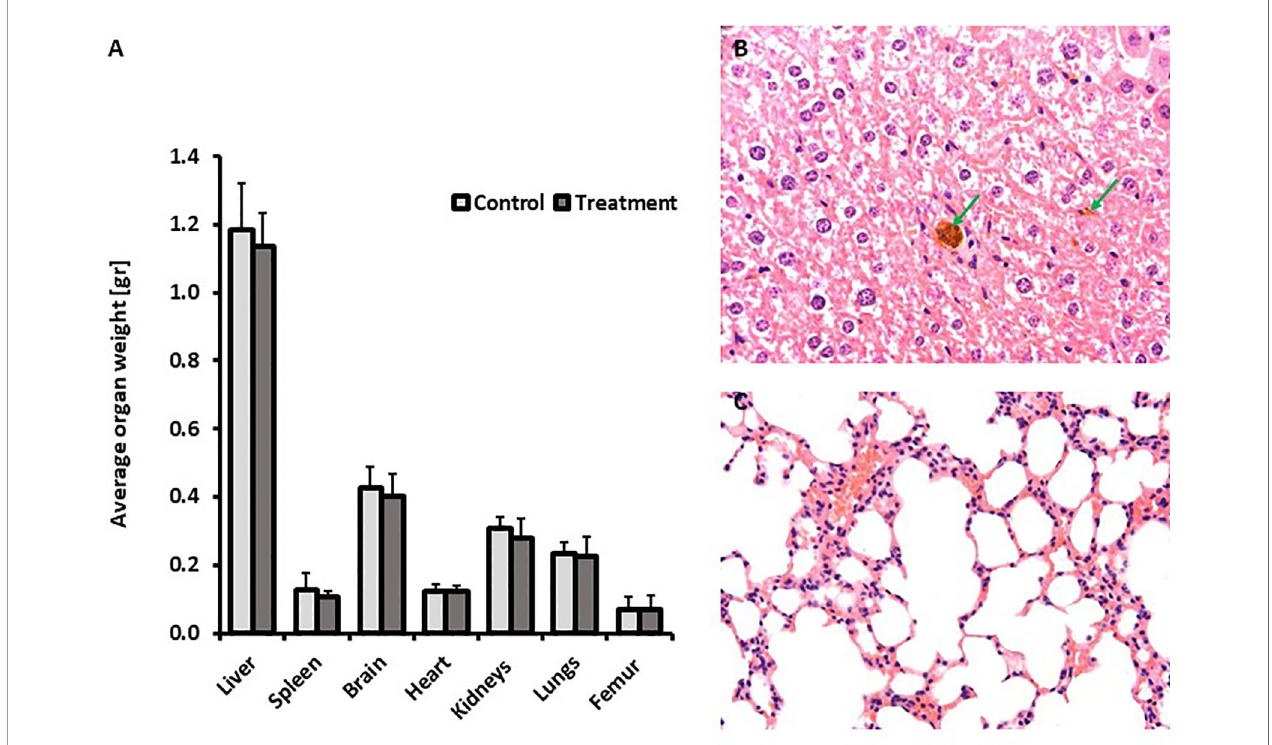
FIGURE 5 | Repeated dose chronic toxicity study. (A) Average organ weight after a follow up period of 25 weeks. (B) Representative liver section (H&E staining) from a treated mouse at 25 weeks post treatment. Green arrows indicate pigment laden macrophages in the liver (Kupffer cells) associated with minimal mononuclear cell in fi ltration. (C) Representative lungs ’ section (H&E staining) from a treated mouse at 25 weeks post treatment. No changes were observed. Images were captured using the Augmentiqs system software (14).